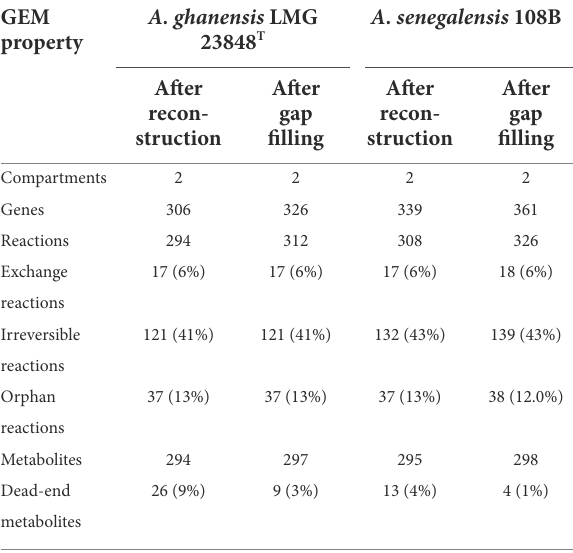
TABLE 3 Composition of genome-scale metabolic models (GEMs) of Acetobacter ghanensis LMG 23848 T and Acetobacter senegalensis 108B after automated reconstruction and curation-based gap filling. GEM